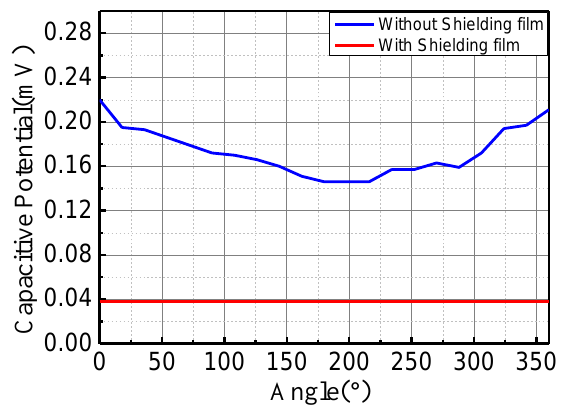
Figure 14. Influence of aluminum shielding film.